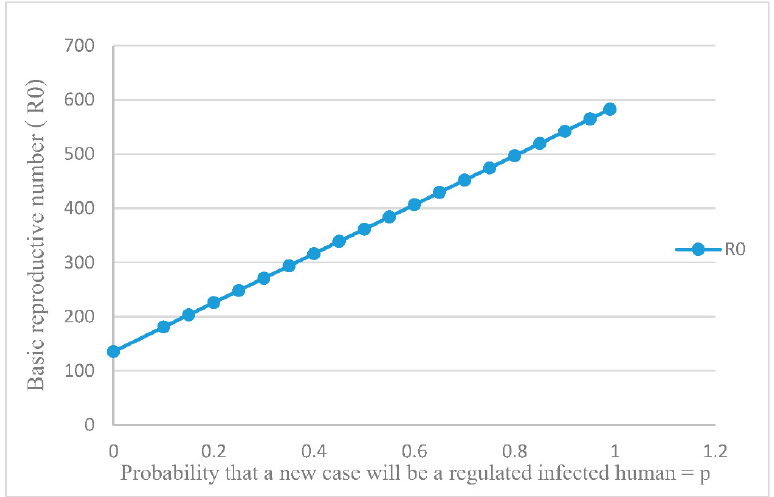
Figure 5. Dependence of R 0 on p (probability that a new case will be a normal infected human) value changes, the R 0 tends to increase.